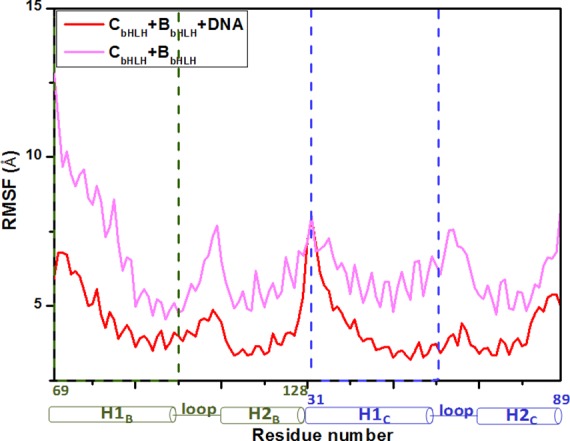
The fluctuations of residues and bases in the CbHLH+BbHLH and CbHLH+BbHLH+DNA models.The fluctuations of residues and bases in the CbHLH+BbHLH (light magenta) and CbHLH+BbHLH+DNA (red) models.